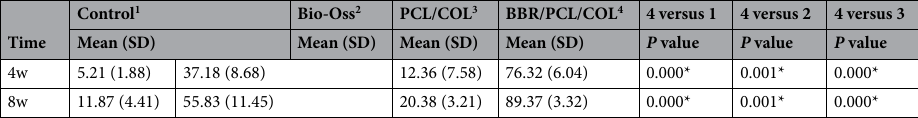
Table 1. Histomorphometric analysis results of percentage of newly formed bone diameter (NBD) (n = 6). SD : standard deviation. 1: Control; 2: Bio-Oss; 3: PCL/COL; 4: BBR/PCL/COL. One-way analysis of variance. *Statistically significant at P < 0.05.